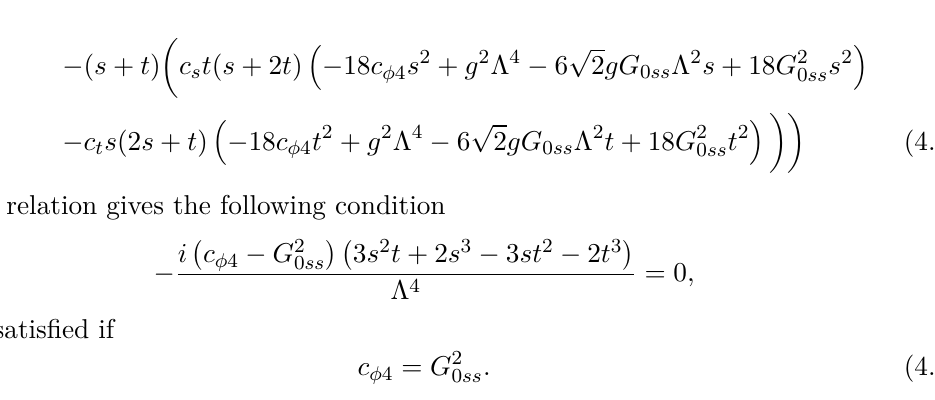
Figure 2 . Feynman diagrams showing the AA → AA process for the general case. The curly lines represents massive spin-1